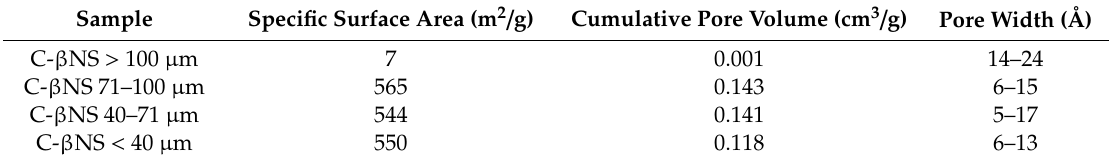
Figure 5. Isotherms of C- β NS ( a ) and C-LcNS ( b ). Table 1. Specific surface area, cumulative pore volume and pore width of the C- β NS. Sample